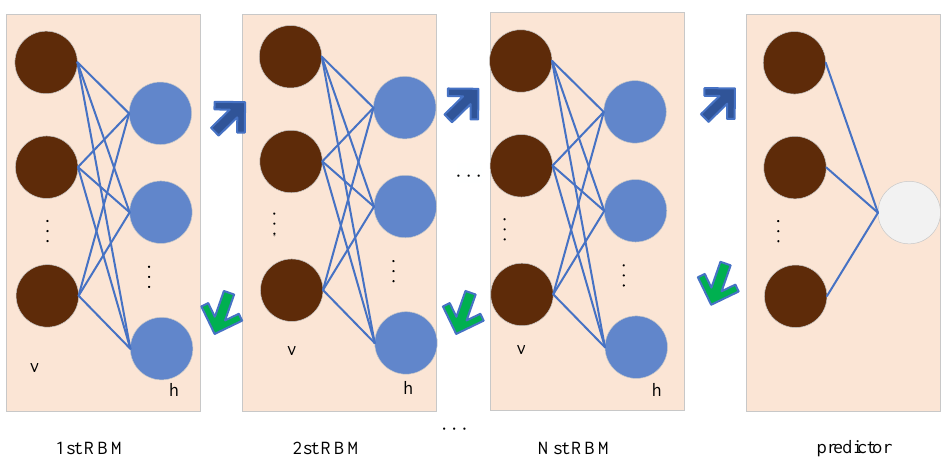
Figure 1. The Deep Belief Network (DBN) architecture.